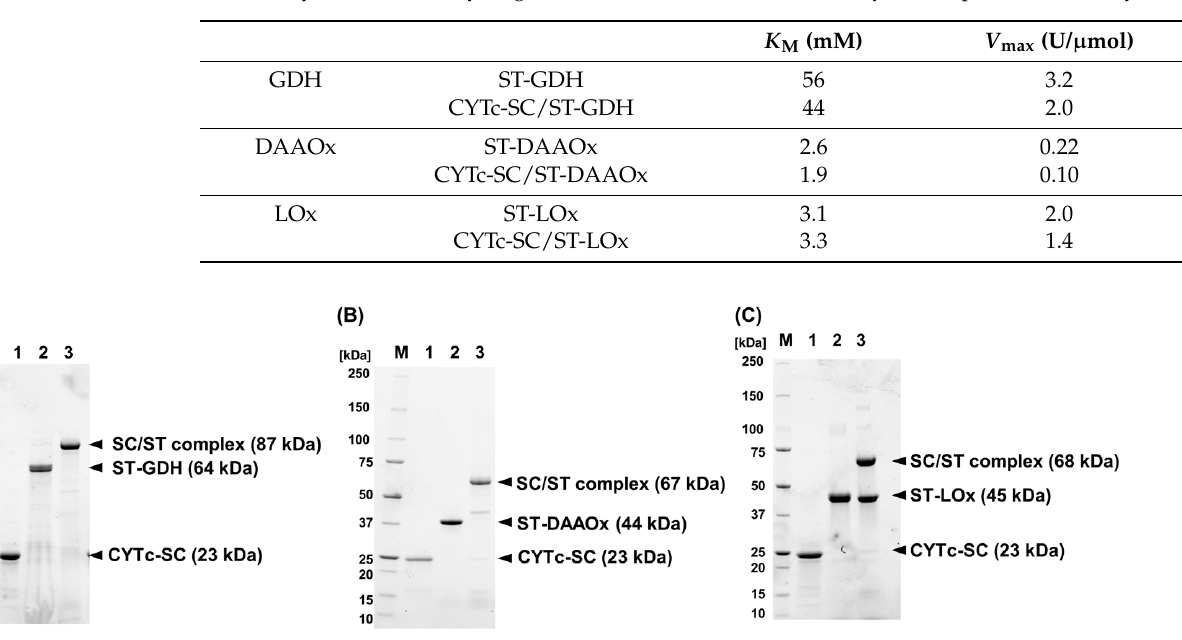
Table 2. Dye-mediated dehydrogenase activities of CYTc-SC/ST-Enzyme complexes or ST-Enzymes.